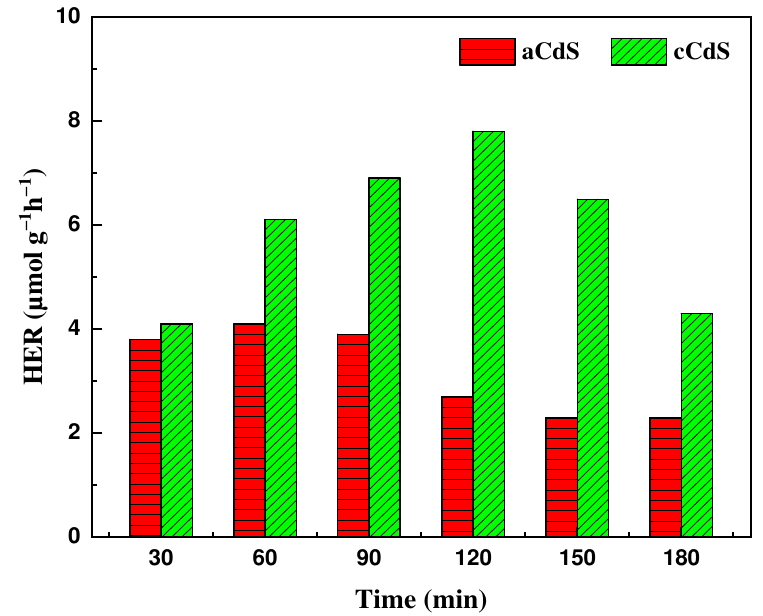
Figure 12. Photocatalytic H 2 production over aCdS and cCdS samples.